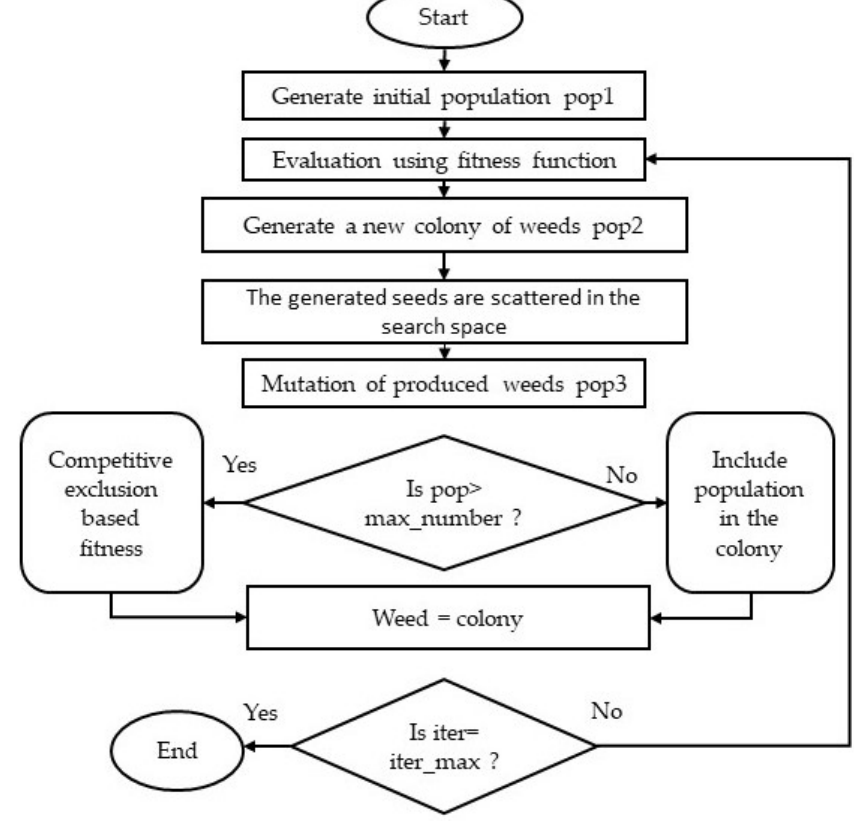
Figure A1. A flow chart of invasive weed optimization.